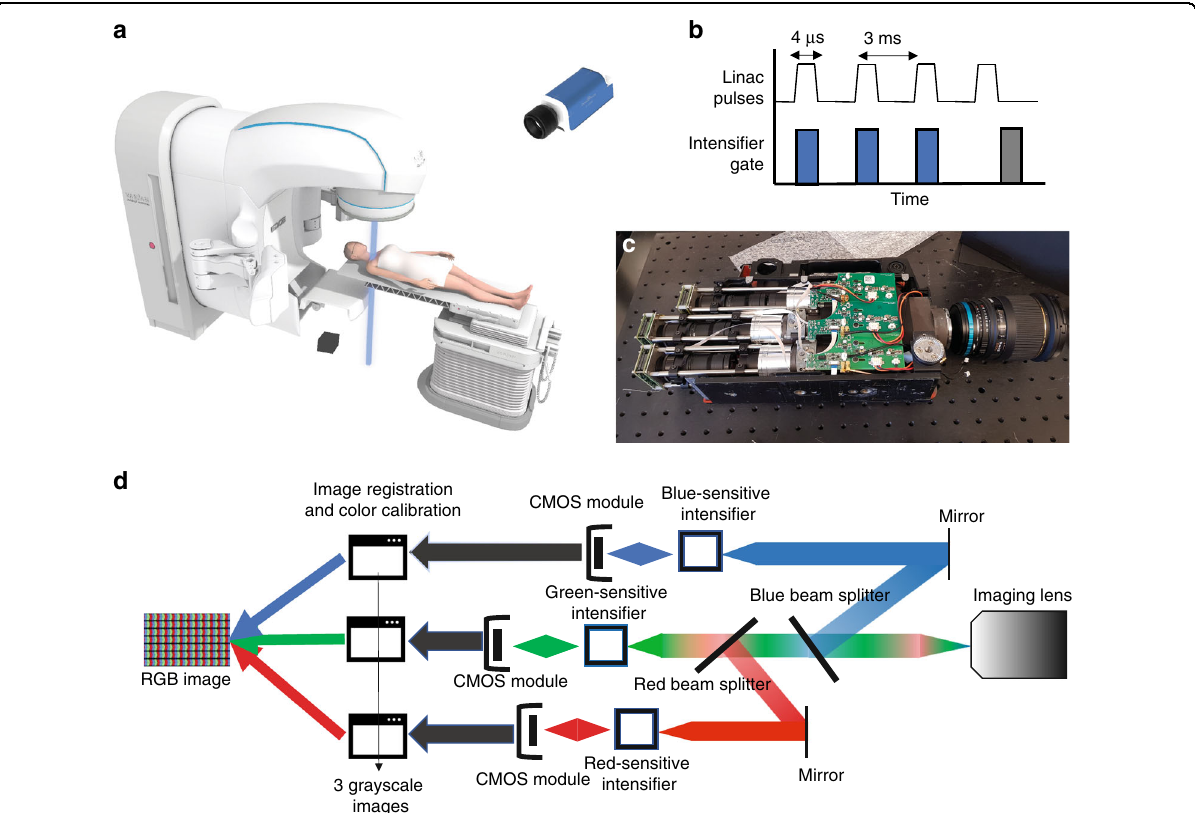
Fig. 1 Imaging scheme and camera design. Time-resolved imaging of Cherenkov emission from patients, as shown in a , is possible because the radiation is delivered in 4 ms pulses at a very low duty cycle, and time-gated intensi fi ed cameras can therefore capture the Cherenkov signal and perform real-time background subtraction ( b ). Performing color Cherenkov imaging requires time-gating in each color channel, necessitating the inclusion of three sets of imaging hardware and appropriate beam splitting optics behind the imaging lens, which is realized in c . A detailed schematic of the custom three-channel camera is highlighted in